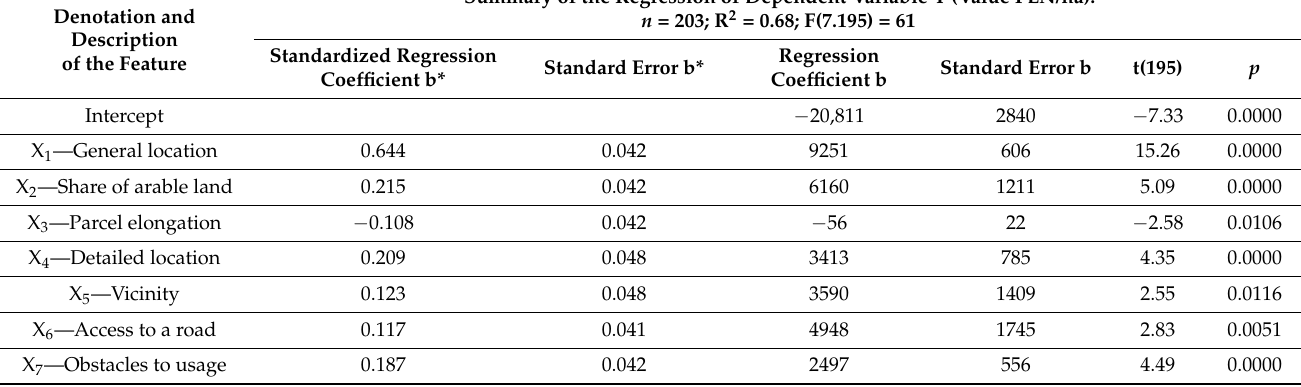
Table 2. Summary of the results of multiple linear